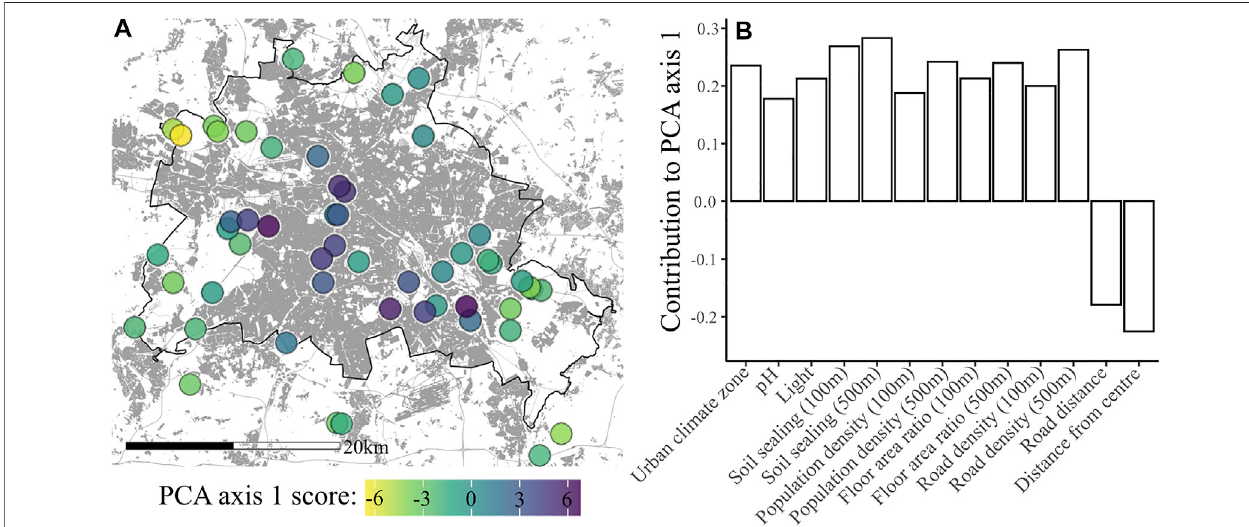
FIGURE 1 | (A) Map of site locations. The colour of the point shows PCA axis one score, representing urbanity. The black line shows the border of Berlin and grey areas denote built up areas. (B) Major contributing variables to PCA axis 1, which can be categorised as an urban syndrome. For plots of all three of the main PCA axes please see Supplementary Figure S1 , with biplots in Supplementary Figure S2